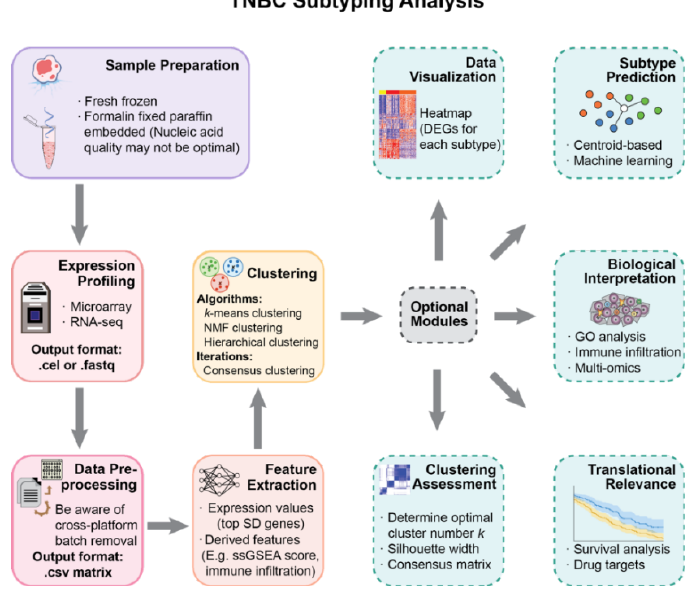
Figure 1. A modularized pipeline for TNBC subtyping. Each step provides alternative methods and data types. Several optional modules are listed for downstream analysis after subtype discovery. This pipeline is also applicable for similar research in other cancer types.